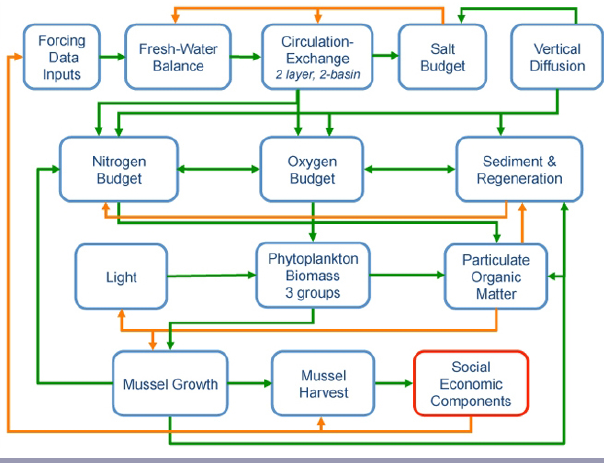
Fig. 5 . The main functional components of the simulation model based on the simulation software EXTEND™-Sim. The green lines are key interactions and the orange lines indicate strong feedback loops. Note that some variables such as phosphate, silicate, and zooplankton are not yet included in the